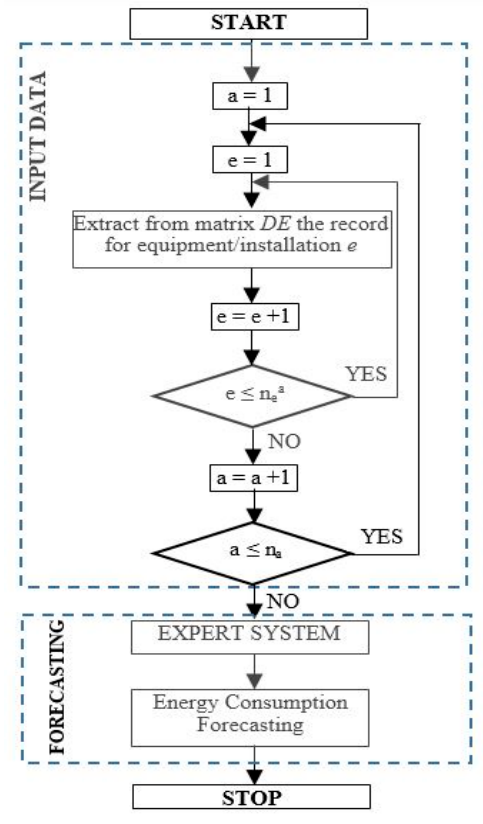
Figure 7. The flowchart of expert system-based aggregated method.